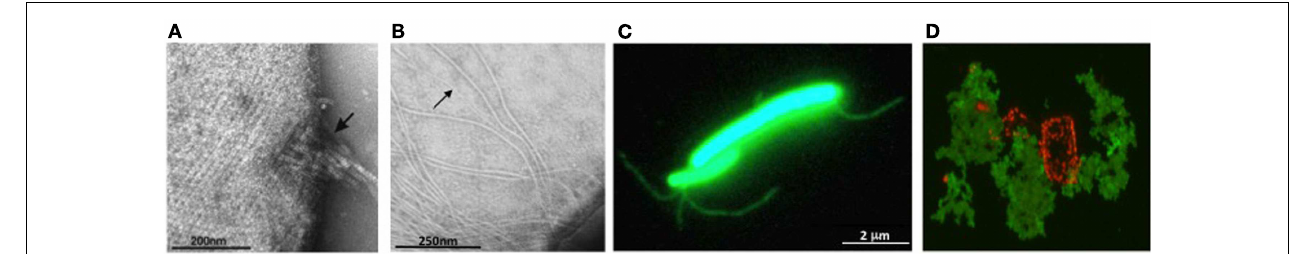
et al., 2008). (C) Non-type IV Mth60 fimbriae of planktonic M. thermoautotrophicus cells by staining with AlexaFluor®-488 (Thoma et al., 2008). Image courtesy of R.Wirth, University of Regensburg, Germany. (D) Secreted halomucin complexes (stained green with specific antibody coupled to fluorescein) surrounds quadratic Haloarcula marismortui cell (stained red by Nile blue for polyhydroxy butyrate). Unpublished image, courtesy of